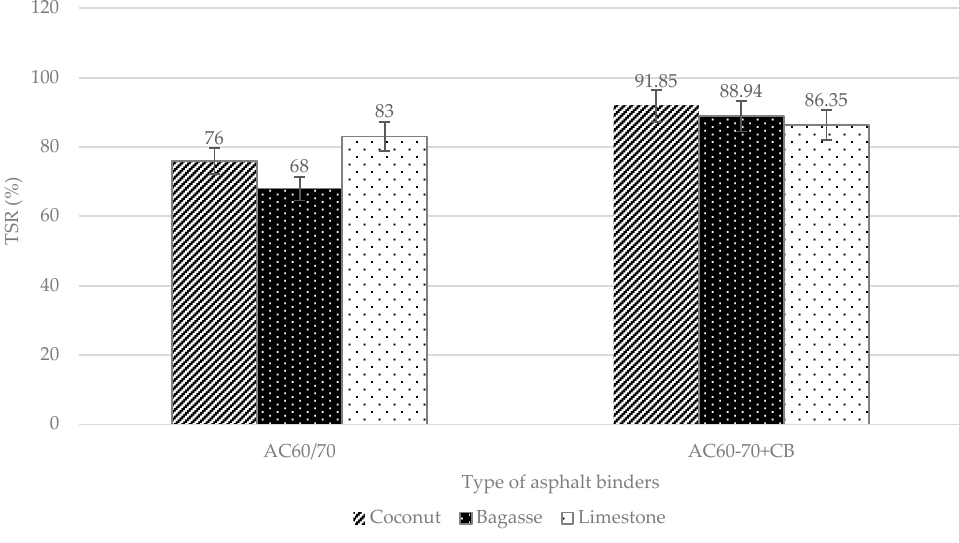
Figure 7. TSR in dense mixture samples.